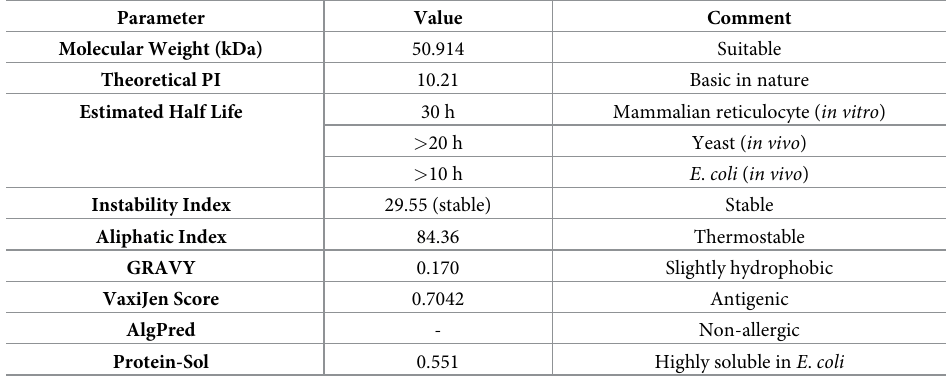
Table 2. Physiochemical, immunogenic and solubility properties of vaccine protein.